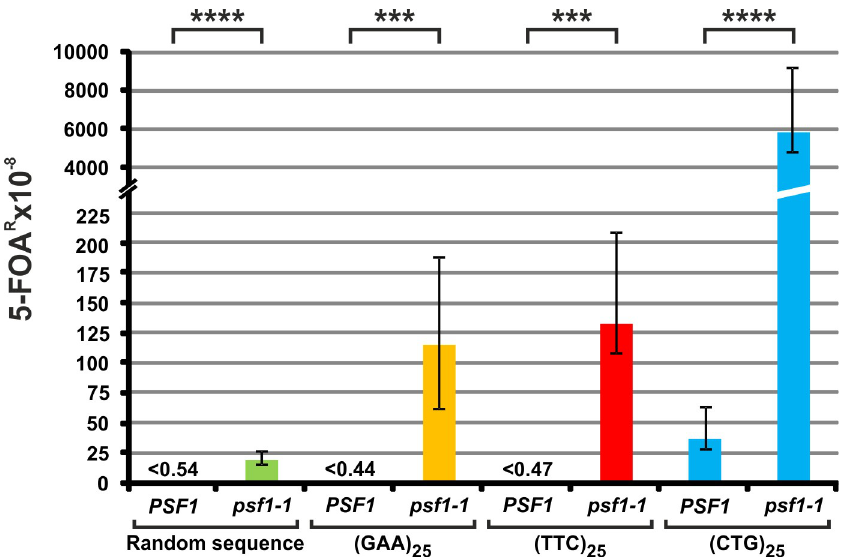
Fig 1. The psf1-1 allele enhances chromosomal trinucleotide repeat instability in yeast. The 5-FOA R mutation rates were determined at 23˚C for yeast cells carrying the analyzed sequences; the values are medians with 95% confidence intervals calculated from data for at least ten cultures of each strain; the p -values for psf1-1 mutants versus wild-type strains were calculated using the nonparametric Mann-Whitney U statistical test ( ���� p � 0.0001; ��� p � 0.001). All associated p -values are presented in the S1 Table.